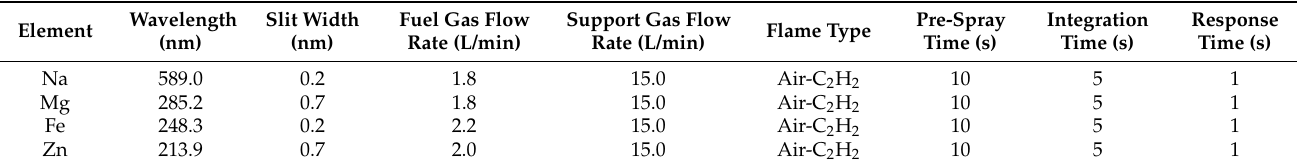
The number of injections of the solutions in the flame was: standard solution—5; blank solution—3; sample solution—3. In order to eliminate analytical errors, each sample was analyzed three